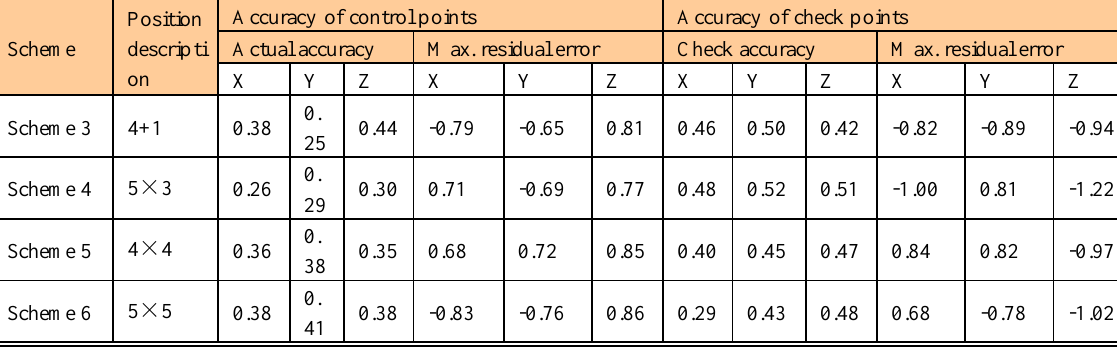
Table 5 the result of 2Dimensional affine transformation